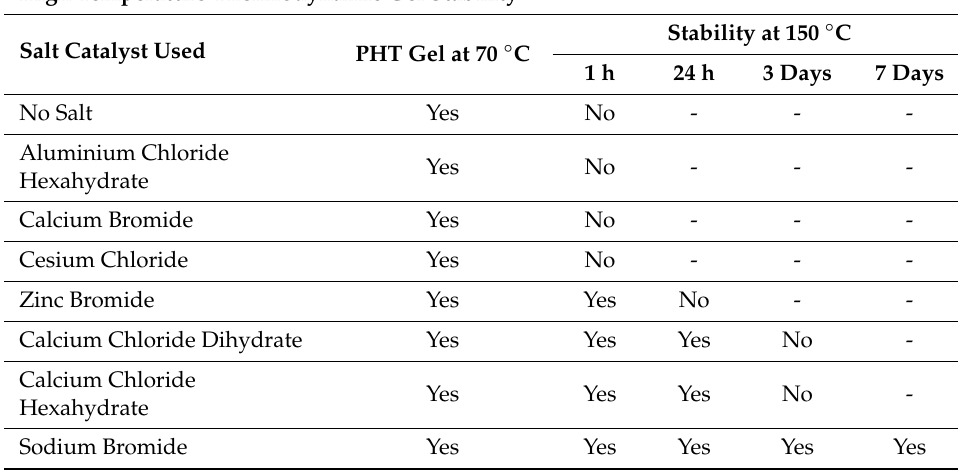
Table 5. Summary of PHT